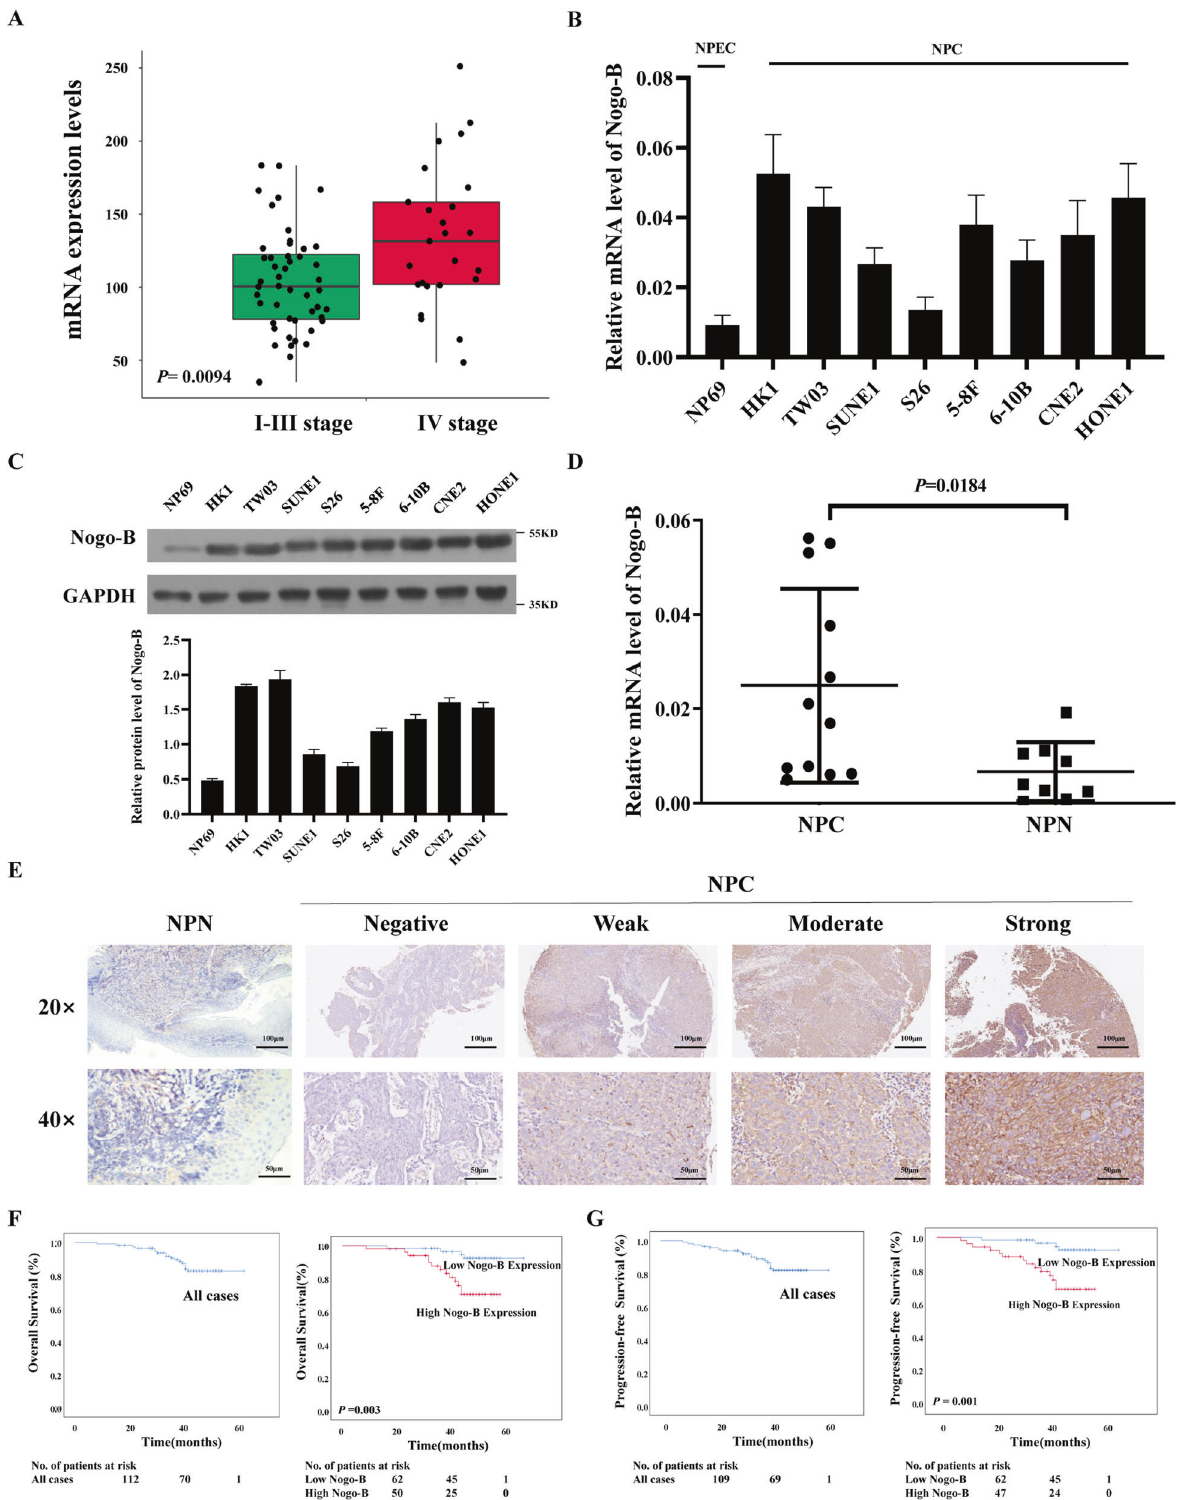
Lung metastasis model The animal experiments were performed in BALB/c-nude female mice (16 – 18 g) at age 5 – 6 weeks, which were purchased from Model Organisms Laboratories (Shanghai, China). Lung metastasis models were established as described in our previous study [18]. CNE2 (5 × 10 5 ) and TW03 (1 × 10 6 ) cells stably overexpressing vector or Nogo-B were